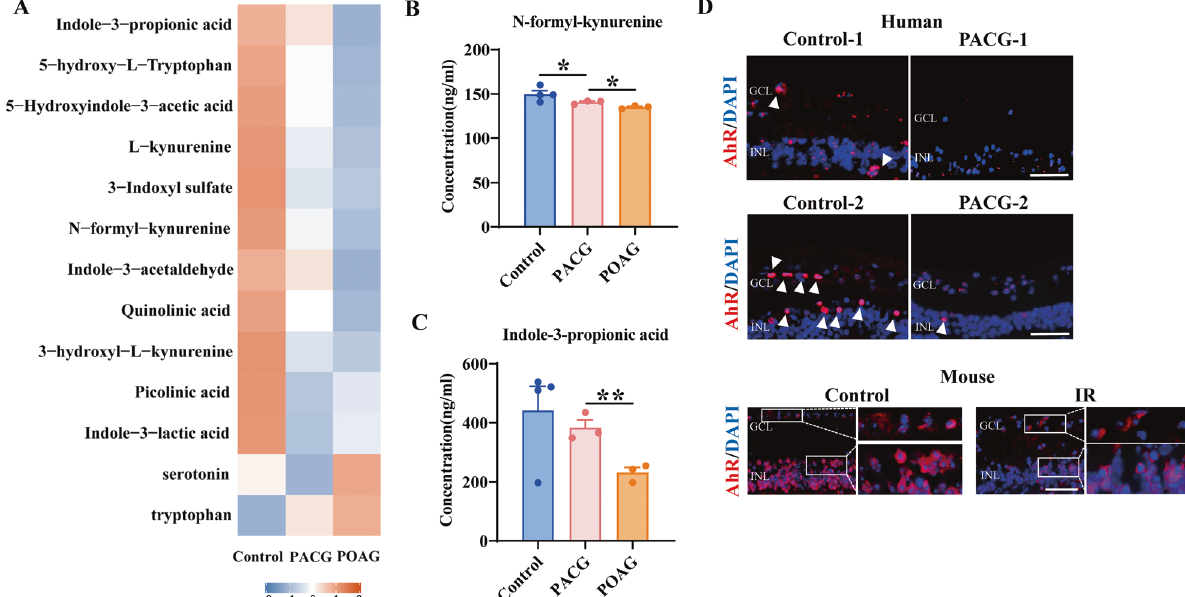
Fig. 1 Tryptophan metabolites and retinal AhR were abnormally expressed in glaucoma patients. A Metabolomics of serum from control ( n = 4), PACG ( n = 3) and POAG ( n = 3) patients to detect the differential tryptophan and tryptophan metabolites expression signatures. B , C Histogram showing concentration of N-formyl-kynurenine and indole-3-propionic acid of three groups. D Immuno fl uorescence staining showed reduced expression of AhR (red) in human retinal sections from PACG patients ( n = 2) than that of Control group ( n = 2), and in mice retinal sections from IR injury at day 1 ( n = 3) than controls ( n = 3). Cell nuclei were counterstained with DAPI (blue). GCL ganglion cell layer, INL inner nuclear layer. Scale bar = 50 µm. * P < 0.05, ** P < 0.01, P value was obtained by one way